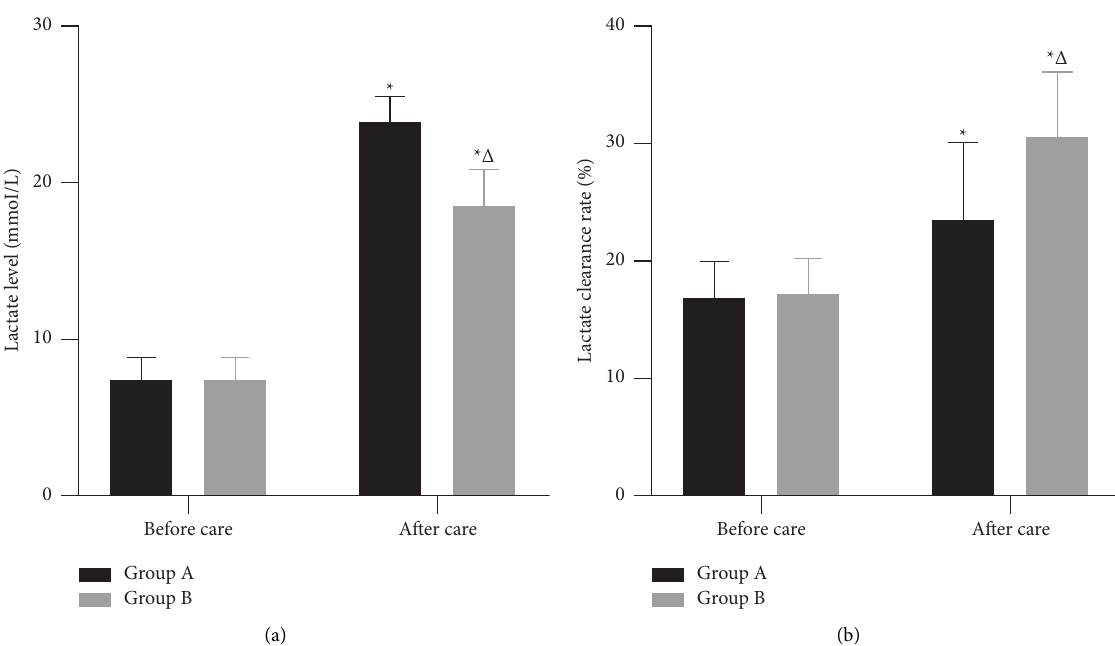
Figure 1: Blood lactate indicator. Note . (a). Lactate level (mmol/L). (b). Lactate clearance rate (%). ∗ and △ represent a comparison with the same group before care and group A after care, respectively, P < 0 . 05.